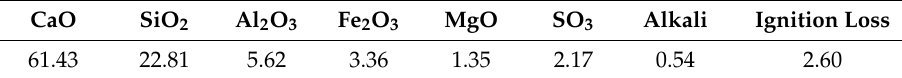
Table 2. The chemical compositions of Portland cement (%).